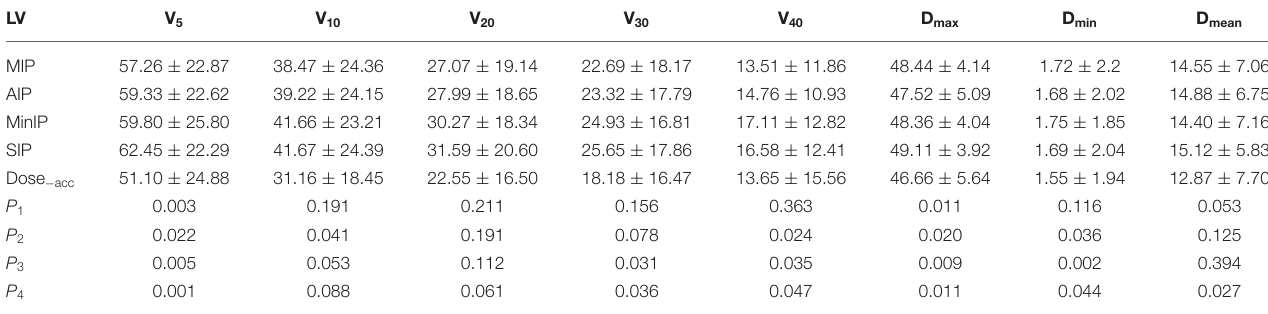
TABLE 2 | Image changes in the dose-volume indexes of the LV ( x ± s)%.